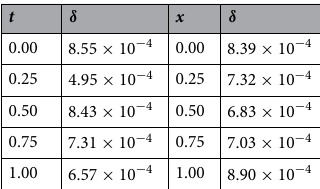
Table 3. The relative errors corresponding to different time and space